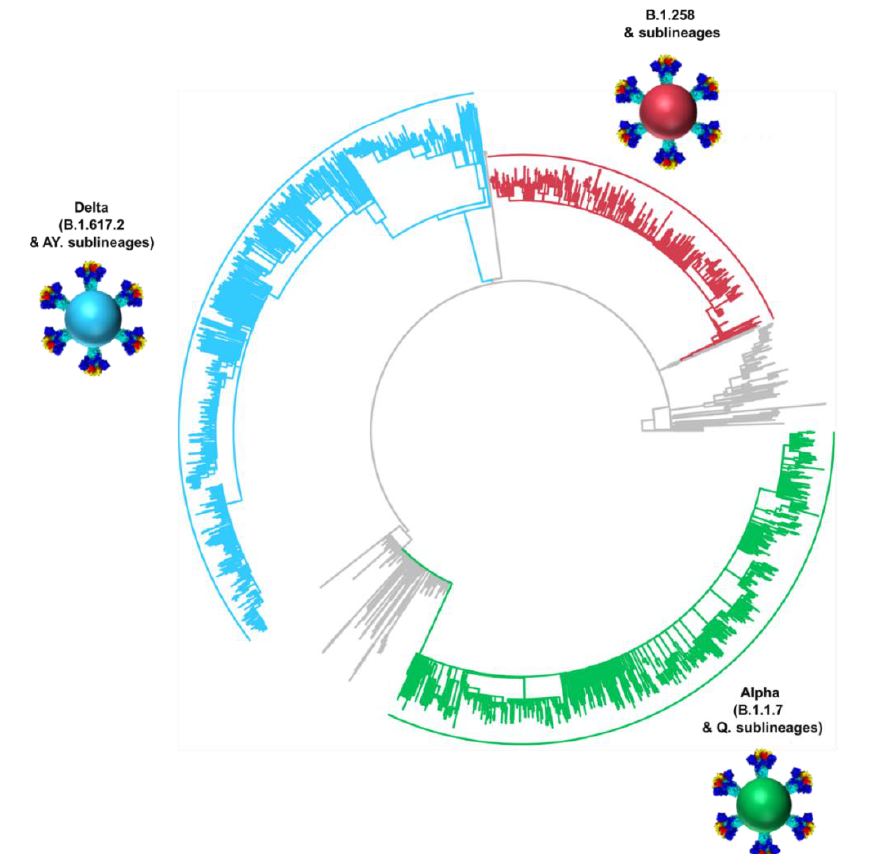
Figure 5. Time-scaled maximum likelihood phylogeny of all available Cypriot SARS-CoV-2 genomes. The sequences of the most prevalent lineages of the second wave (B.1.258 & sublineages), third wave (Alpha, B.1.1.7 & Q. sublineages), and fourth wave (Delta, B.1.617.2 & AY. sublineages) are highlighted in red, green and blue, respectively. Lineages that did not classify and/or cluster with B.1.258, Alpha, and Delta are denoted as “Other lineages” and indicated in gray.